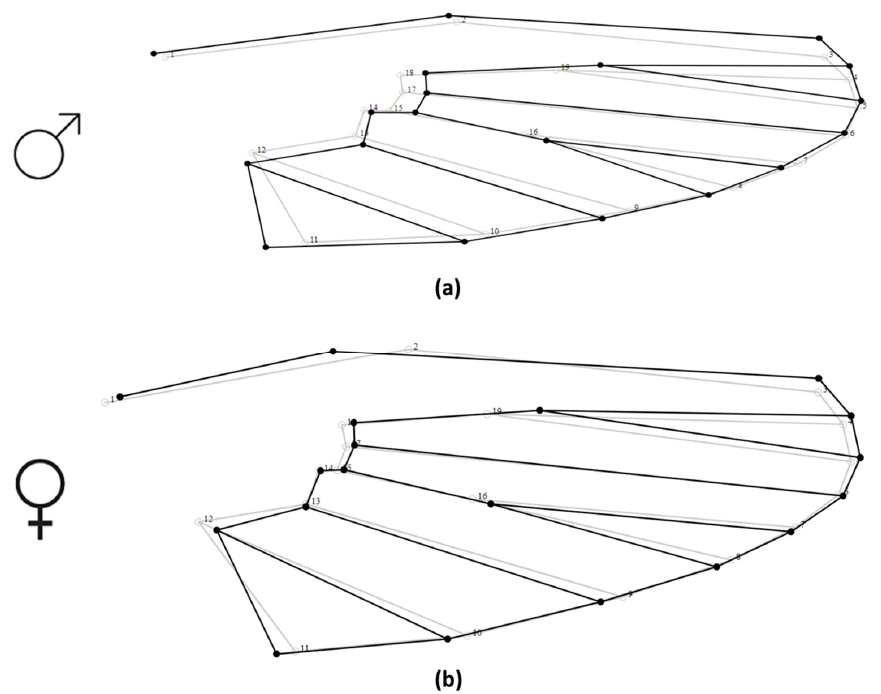
Figure 3. Wireframe diagram from PCA displaying the mean value of wing shape variation in ( a ) male and ( b ) female Cs. longiareolata mosquitoes. The light-colored wireframe represents the mean wing shape, while the dark-colored wireframe represents generated principal component analysis for the wing shapes.